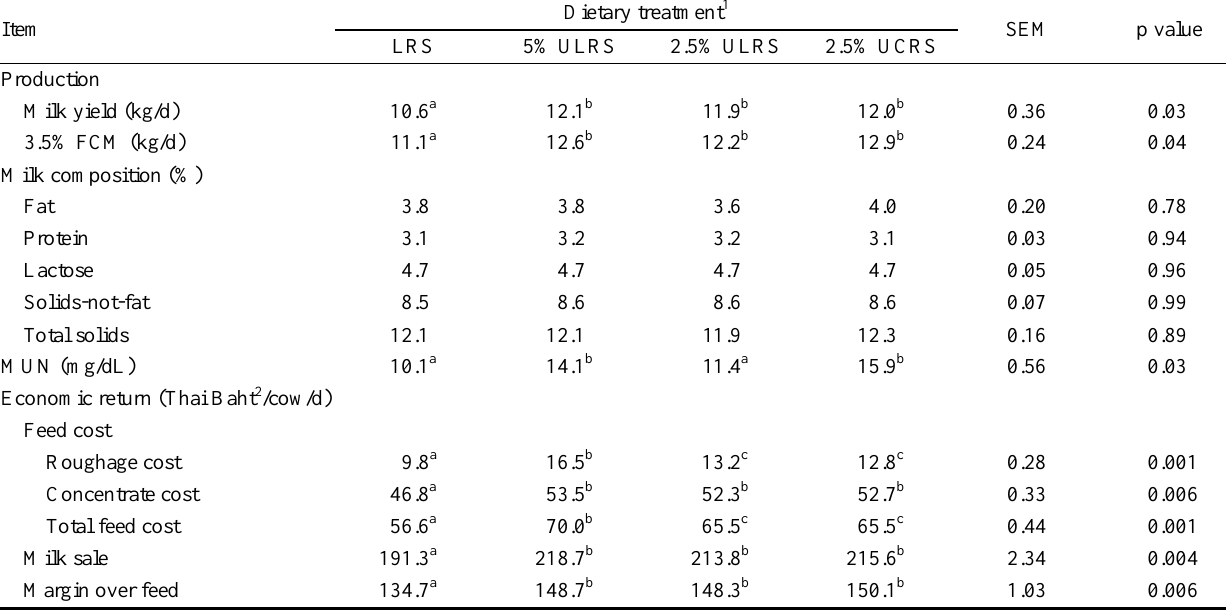
Table 5. Effects of physical forms and urea treatment of rice straw on milk yield, composition and economic return in lactating dairy cows